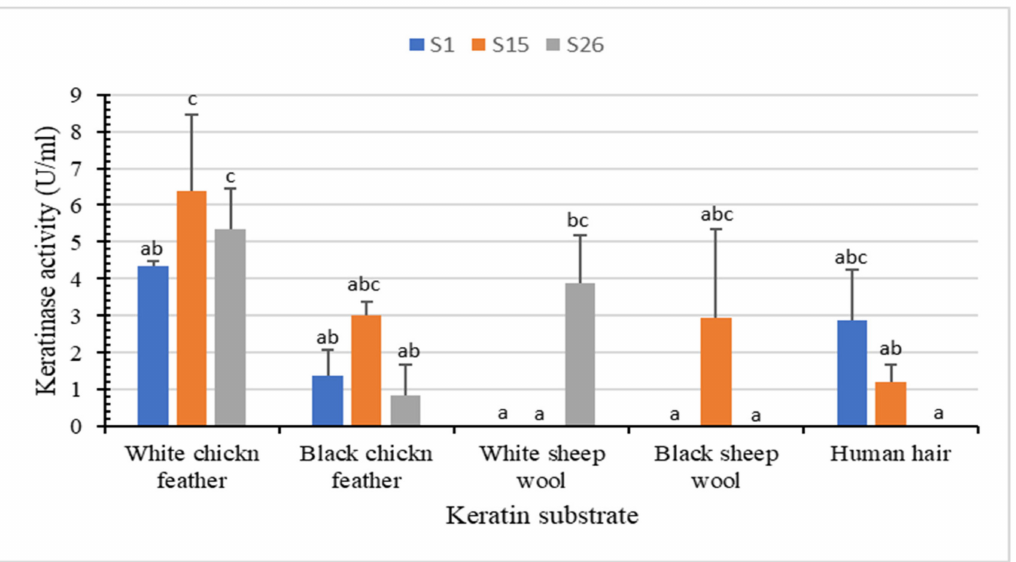
Figure 3. In vitro biodegradation of different keratin substrates (white chicken feather, black chicken feather, white sheep wool, black sheep wool, and human hair) after incubation with the keratinolytic bacteria for 72 h at 45 ◦ C. Bars are the standard error of the mean. Mean with the different letters are significantly different according to Duncan’s at p <